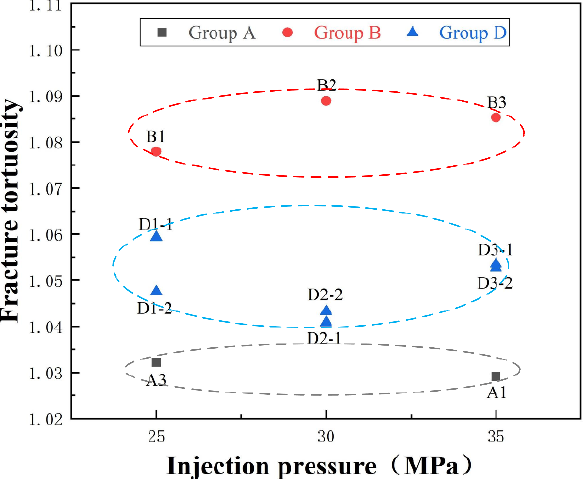
Figure 9. The tortuosity of longitudinal fractures on the vertical surfaces of specimens in group A, B and D.